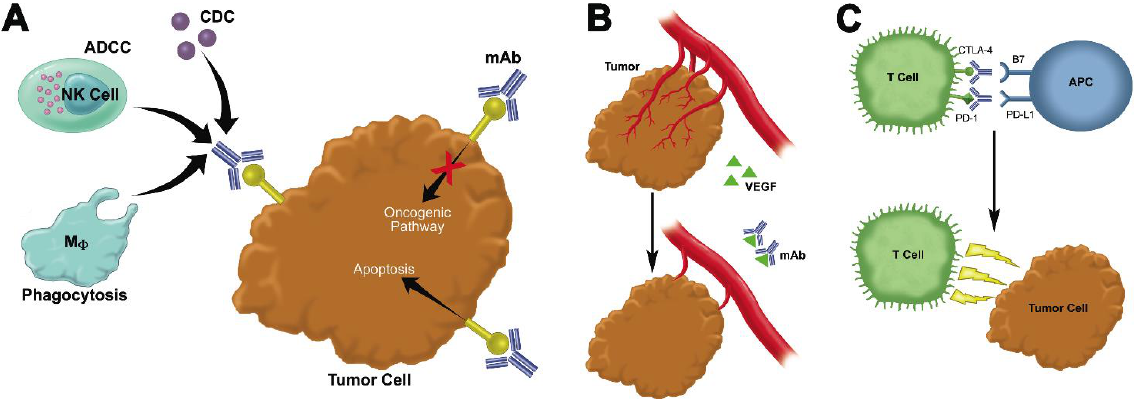
Figure 1. Mechanisms of targeting tumors using monoclonal antibodies ( A ) The first class of mAbs binds directly to tumor cells and induces apoptosis or antagonizes oncogenic pathways. The Fc region of the mAb may also induce antibody-dependent cellular cytotoxicity (ADCC), complement-dependent cytotoxicity (CDC) or phagocytosis of the tumor cell. ( B ) The second class of mAbs blocks growth promoting pathways in the stroma. In the example shown here, an anti-VEGF mAb acts to prevent angiogenesis. ( C ) The third class of mAbs, immune checkpoint inhibitors, blocks the interaction of inhibitory receptors expressed on activated T cells (CTLA-4, PD-1) with ligands on antigen presenting cells (B7, PD-L1) or tumor cells (PD-L1 or PD-L2). This therapy prevents the attenuation of the T cell response and allows activated T cells to kill tumor